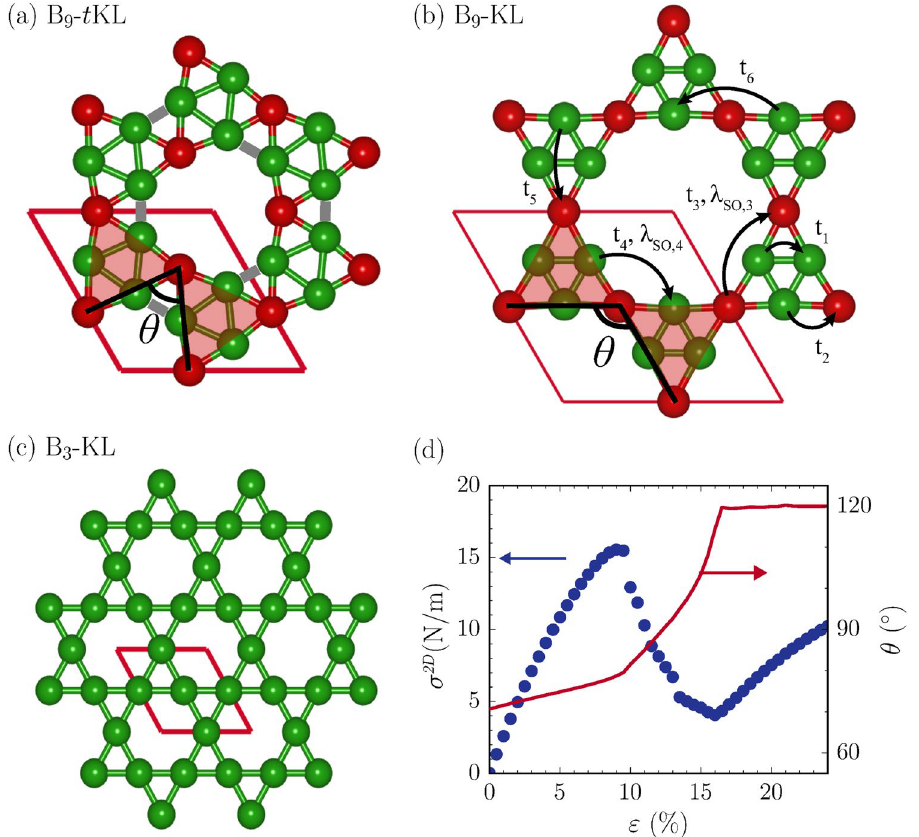
Figure 3. Strain effect on atomic structure. Atomic structures for ( a ) B 9 - t KL, ( b ) B 9 -KL, and ( c ) B 3 -KL. Red balls denote the B atoms sharing large triangles in B 9 - t KL and B 9 -KL. In ( a ), gray lines represent the bonds between large triangles, which are broken in B 9 -KL. ( d ) The 2D stress ( σ 2 D ) and the angle between two large triangular units ( θ ) are plotted as a function of biaxial strain.